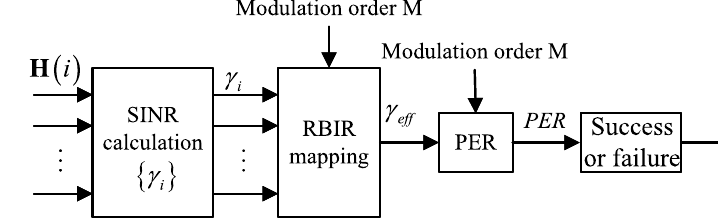
Fig. 8 Flowchart of PER prediction based on